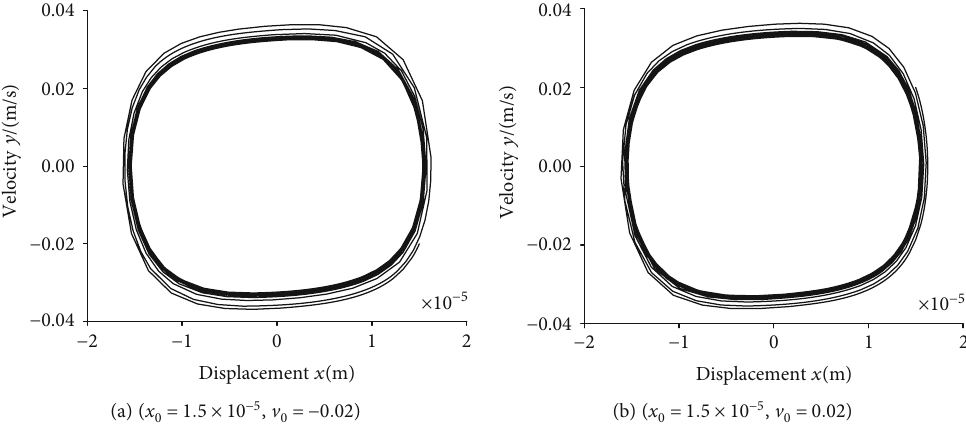
= 1 : 8A , q = 1 : 6 × 10 − 4 m 3 /s . 0 0